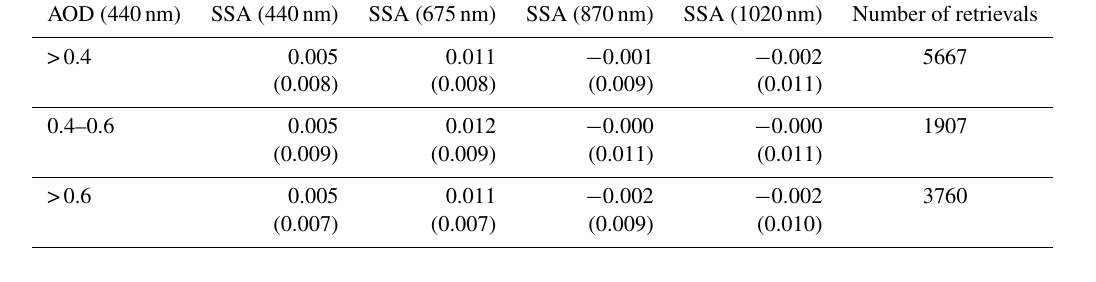
Table 10. Statistics, average values and standard deviations (in parentheses) of the difference in SSA retrievals of V2 and V3 for the Kanpur site. The difference is defined as V3 − V2.